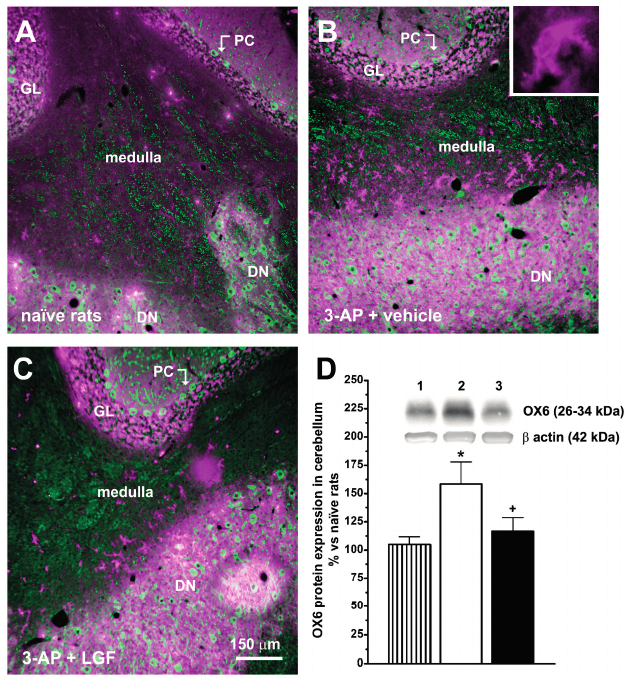
Figure 5. Liver growth factor reduces OX6 immunodetection and protein expression in the cerebellum of 3-acetylpyridine ataxic rats. Panels A to C show OX6 (magenta) and β -tubulin III (green) immunoreactivity in the cerebellum of 3-AP-lesioned rats. Note that OX6 immunopositive cells in 3-AP-lesioned rats are detected in the medulla near the deep cerebellar nuclei and ( B ) LGF treatment reduces OX6 immunostaining in this structure ( C ) and D shows the detection by western blot of OX6 in the cerebellum of naïve rats ( D , lined bars). Lane 1: naïve rats (control); lane 2: 3-AP + vehicle; lane 3: 3-AP + LGF. Results represent the mean ± SEM of 7 to 15 individual animals. * p ≤ 0.05 vs. naïve rats, layer, DN: deep nuclei.